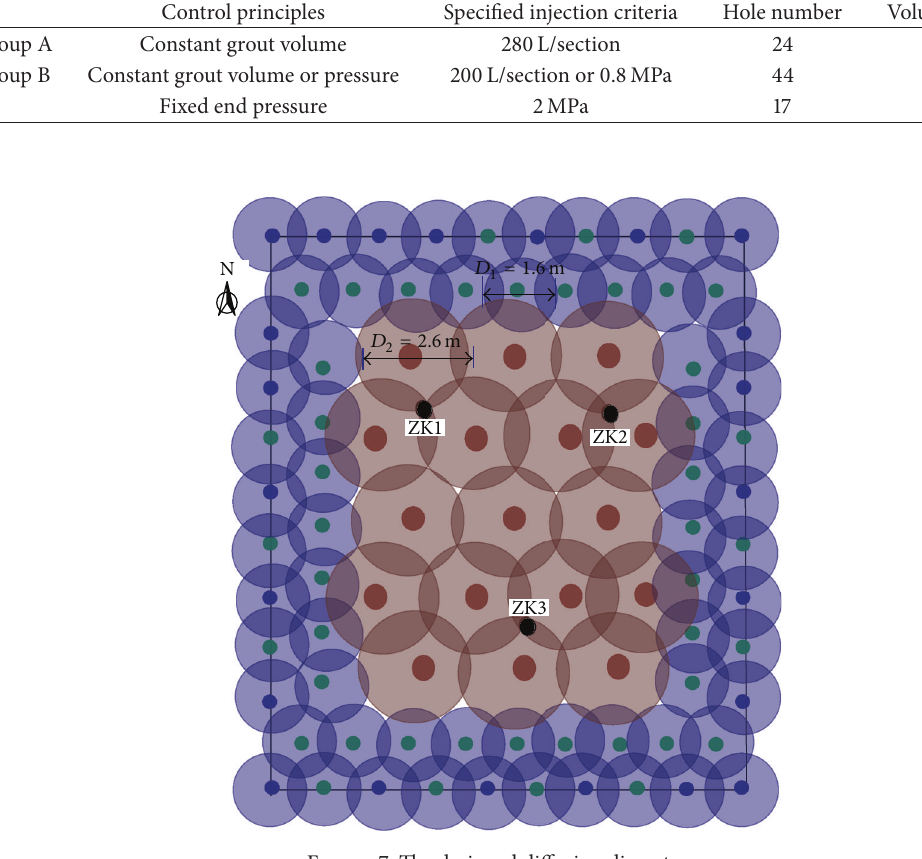
Figure 7: The designed diffusion